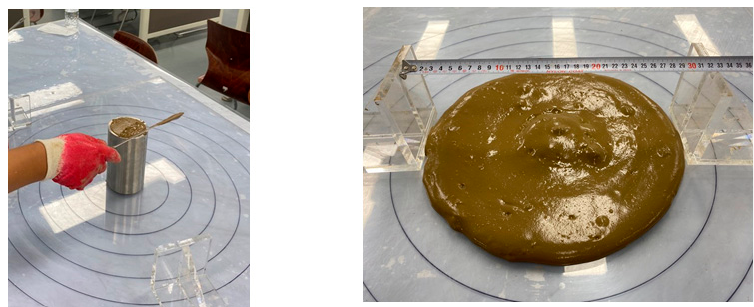
Figure 1. Flow test of CLSM using stone sludge .